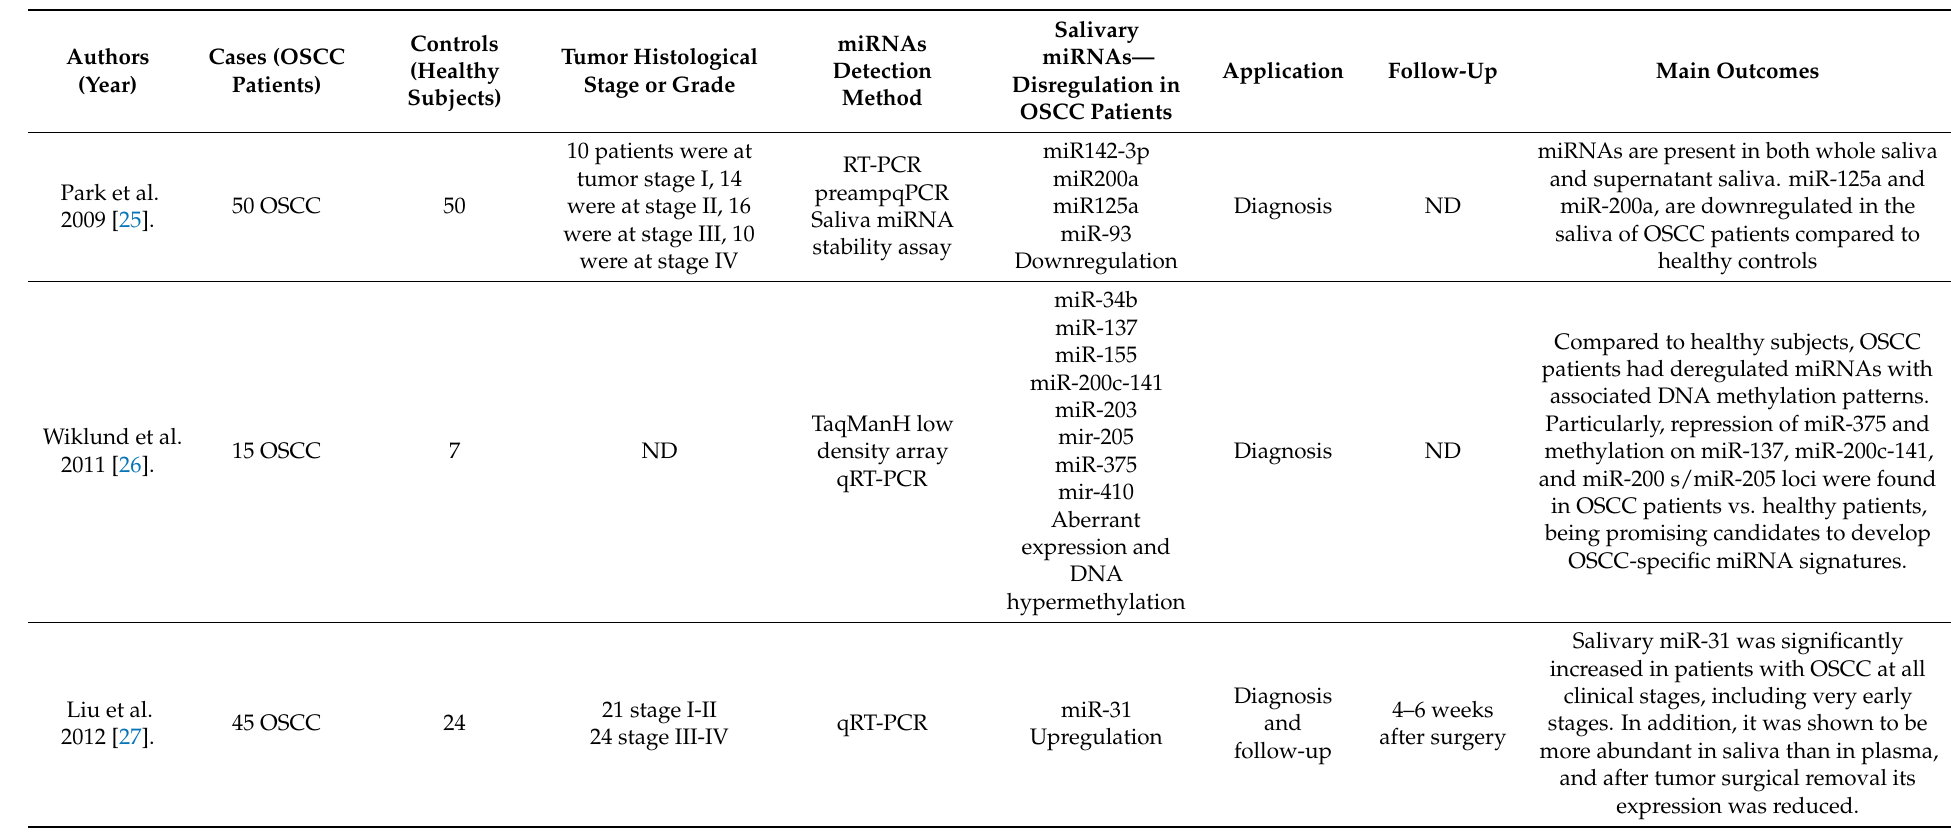
Table 1. Main characteristics of the included